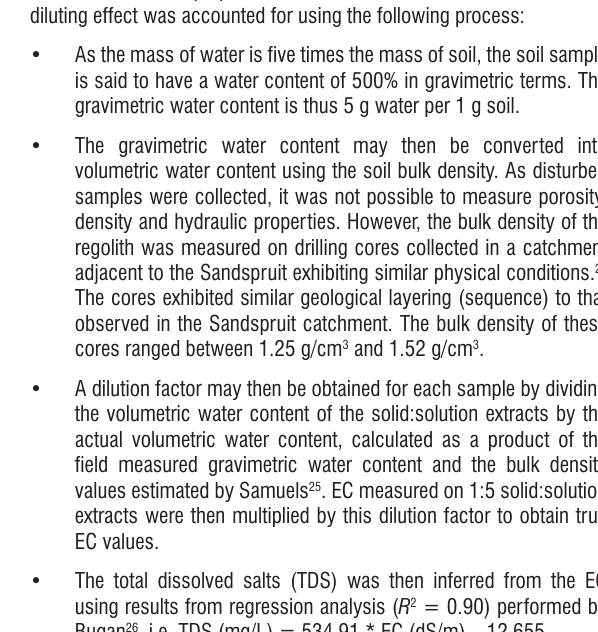
Table 1: Electrical conductivity (EC